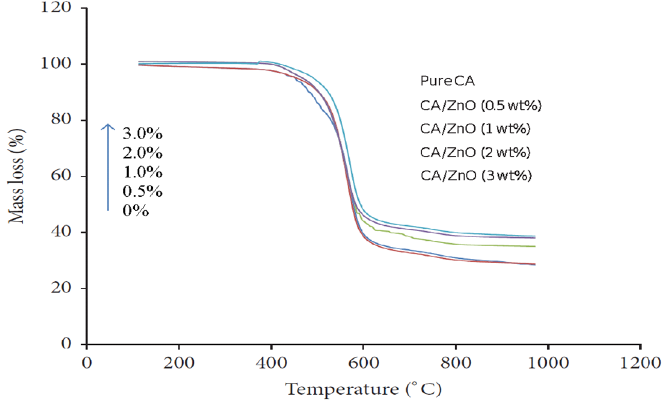
Figure 8. TGA results for increasing decomposition temperature for (0.0, 0.5, 1.0, 1.5, and 2.0 wt%) of ZnO on CA membranes.